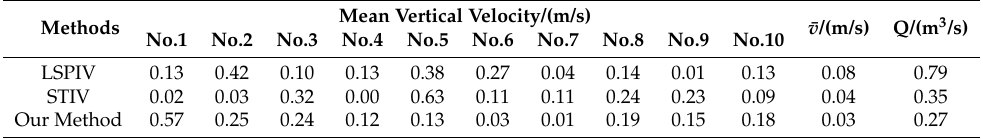
Table 14. Absolute error comparison.